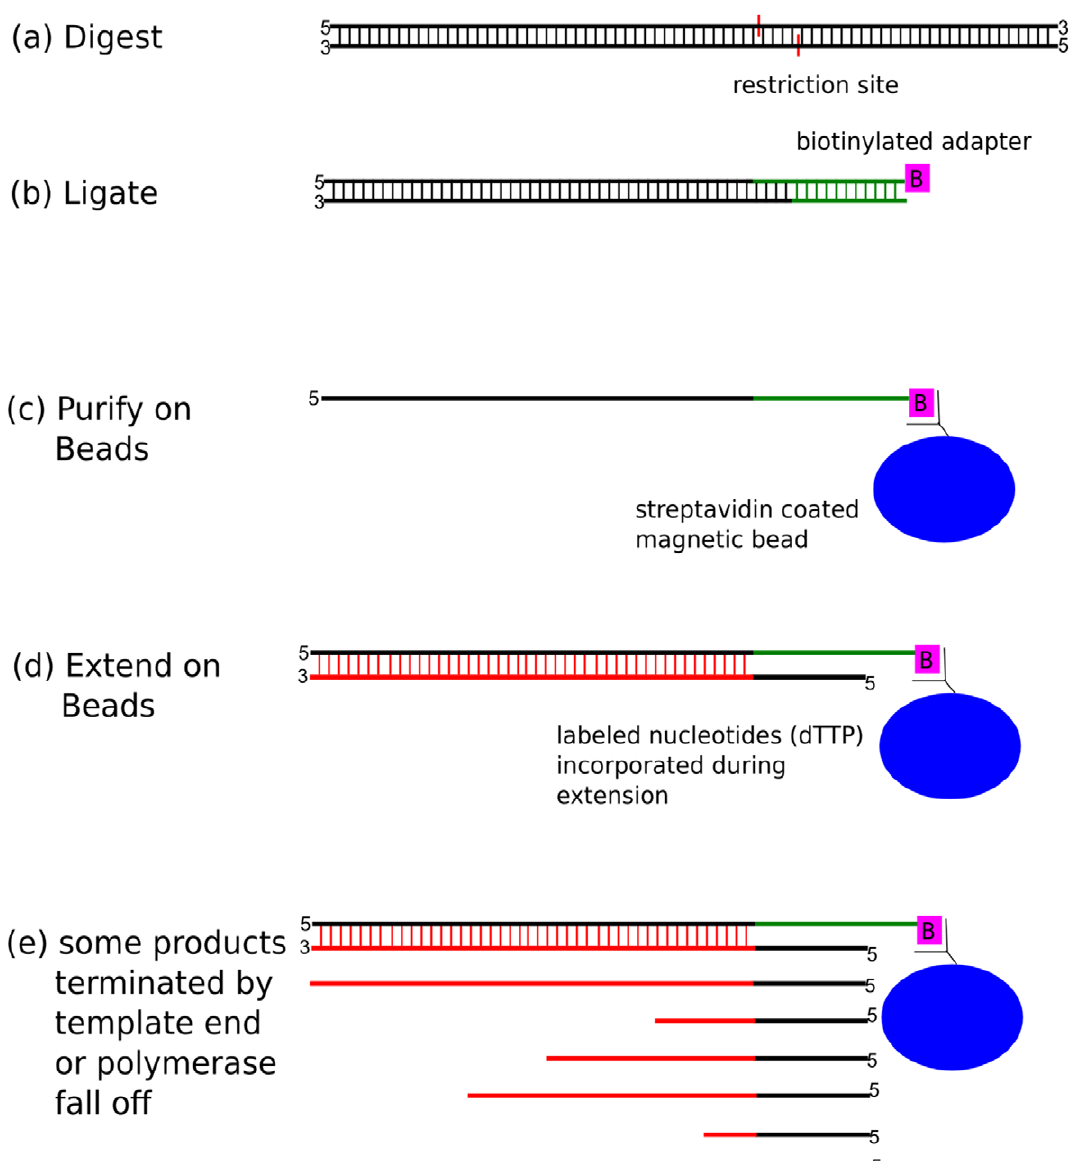
Figure 1. The ruler array method uses a digest-ligate-extend protocol to generate a labeled DNA sample to detect distances between genomic points. (a) One or more restriction enzymes digest the input DNA sample, leaving a set of sticky ends. (b) An adapter DNA molecule is ligated to the ends, providing a biotin moiety for purification of the ligated material and an initiation site for the polymerase extensions. (c) The ligated material is purified using streptavidin coated beads. (d) Primers, DNA polymerase, and labeled nucleotides are added and primer extensions occur. (e) An extension terminates either upon reaching the end of the template molecule or randomly due to the polymerase’s processivity. Since the output material includes many partial extension products, sequences close to the restriction site occur more frequently than do sequences far from the restriction site. When the labeled sample is hybridized to the microarray, probes close to the restriction site yield correspondingly higher intensities than the distal probes. When this material is labeled (the polymerase may incorporate labeled bases or modified bases or the product may be labeled with a system like ULS) and hybridized to a microarray, probes near the restriction site in the genome will observe a high intensity while probes farther away observe lower